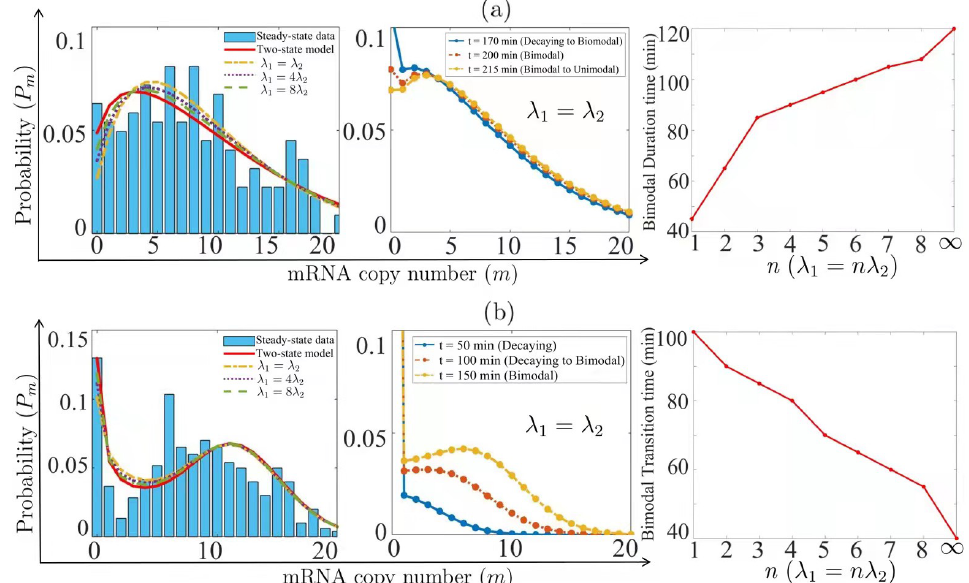
Figure 4. Discriminated dynamic bimodal features of mRNA distribution generated by the two-state model and three-state model. ( a ) The steady-state mRNA distribution data of mouse Mbln2 gene[4] (blue bars) can be well fitted by both models with ( T off δ , γ / δ , v / δ ) = ( 0.71,4.74, 38.8 ) , and λ 1 = n λ 2 with finite n for the three-state model and n → ∞ for the two-state model. Dynamic distribution profiles with δ = 0.0109 min − 1 [22] display an intermediate dynamic bimodal distribution with the longest duration of 120 min for the two-state model, but decreasing durations with respect to n for the three-state model. ( b ) The steady-state mRNA distribution data of E.coli P lac/ara promoter[17] (blue bars) can be well fitted by both models with ( T off δ , γ / δ , v / δ ) = ( 2.53,0.22,13 ) and λ 1 = n λ 2 . Dynamic distribution profiles with δ = 0.014 min − 1 [17] display a dynamic distribution transition from decaying to bimodality, with the transition time as early as 40 min for the two-state model and as late as 100 min for the three-state model with λ 1 = λ 2